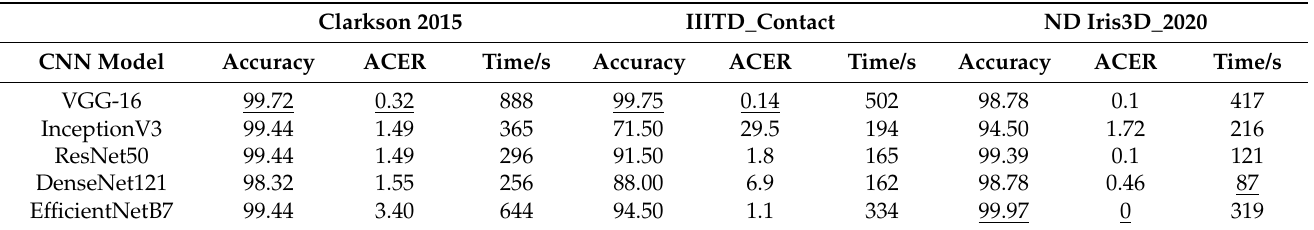
Table 10. Performance evaluation of all pre-trained models for iris liveness detection across all datasets using validation accuracy (%), ACER (%), and testing time